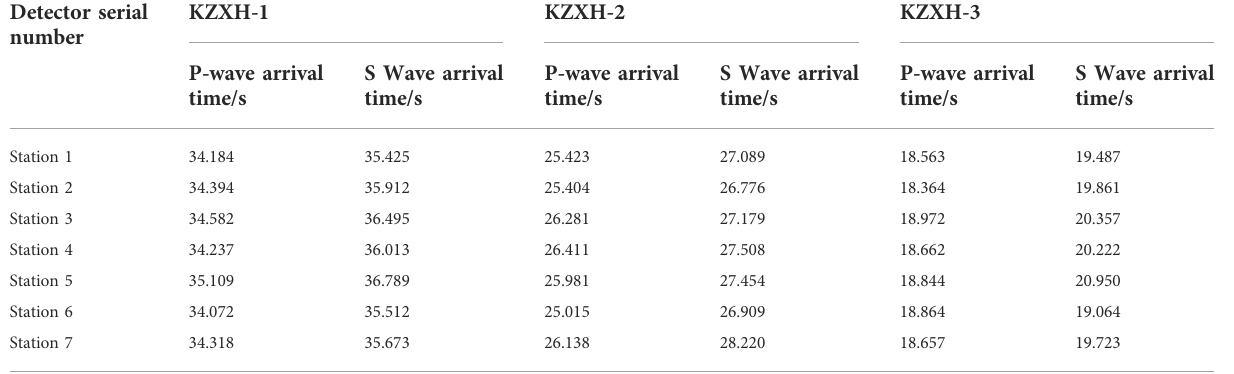
TABLE 7 Arrival-time data of P-wave and S-wave of mine seismic